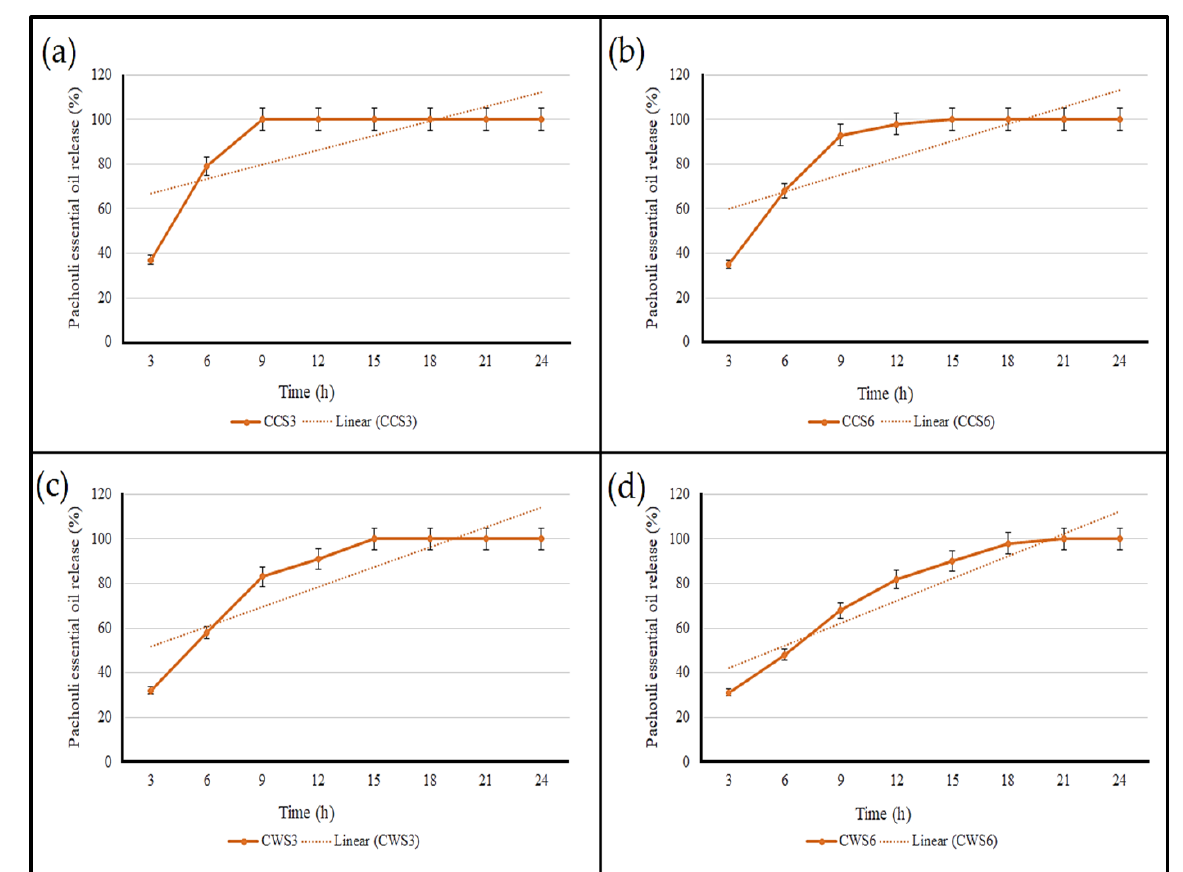
Figure 6. The rate of patchouli essential oil released from loaded hydrogel samples at different time intervals; ( a ) CCS3, ( b ) CCS6, ( c ) CWS3 and ( d ) CWS6.